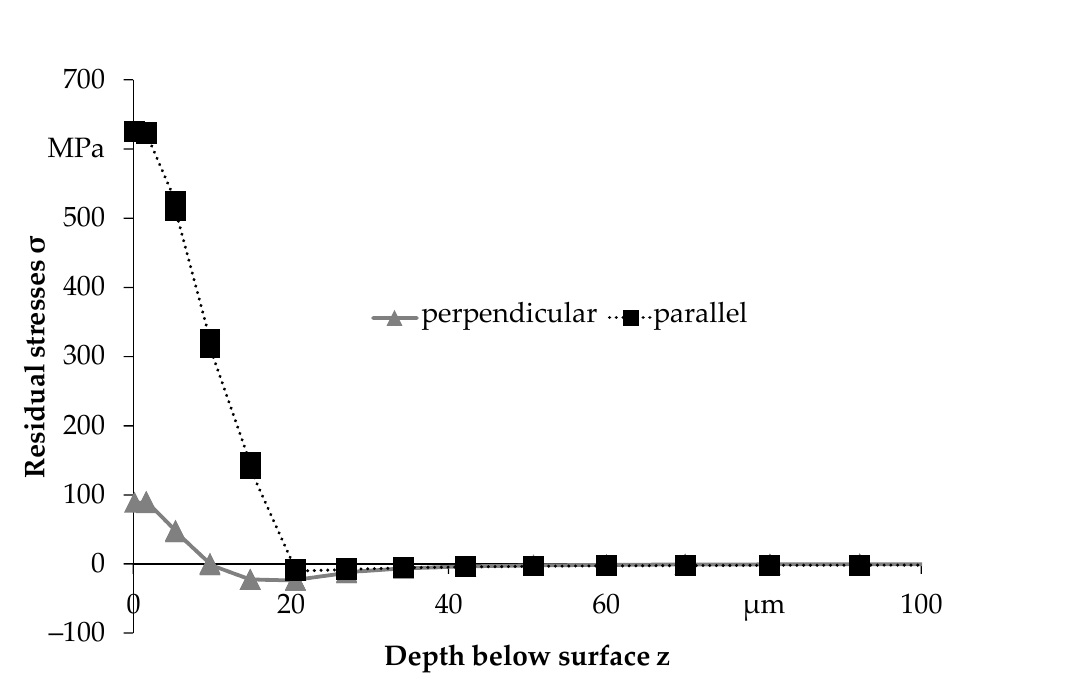
Figure 8. Numerically assessed residual stresses parallel and perpendicular to rolling direction caused by laser heating (F r = 0 N; P L = 750 W; v cw = 7.28 m/min); available in Supplementary Material Residual Stress Data.